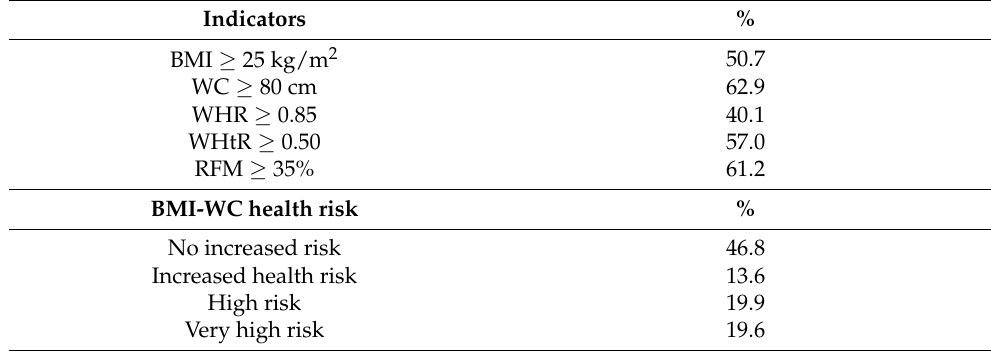
Table 4. Percentage of women at risk of MetS according to anthropometric indicators in Moroccan women ( n = 304). Indicators